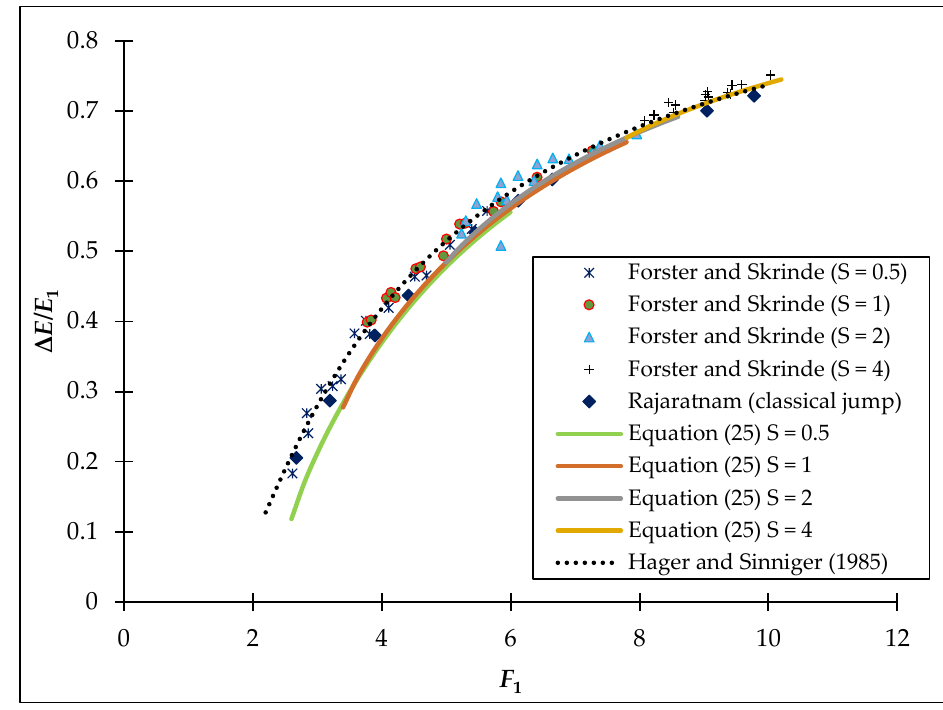
Figure 7. Relative energy dissipation variation with initial Froude number.